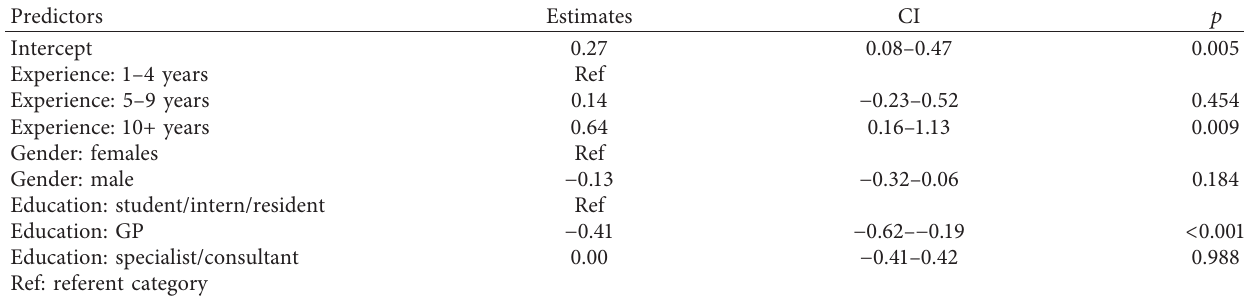
Table 5: Association of demographic characteristics with knowledge regarding advanced caries diagnostic methods in clinics. Predictors